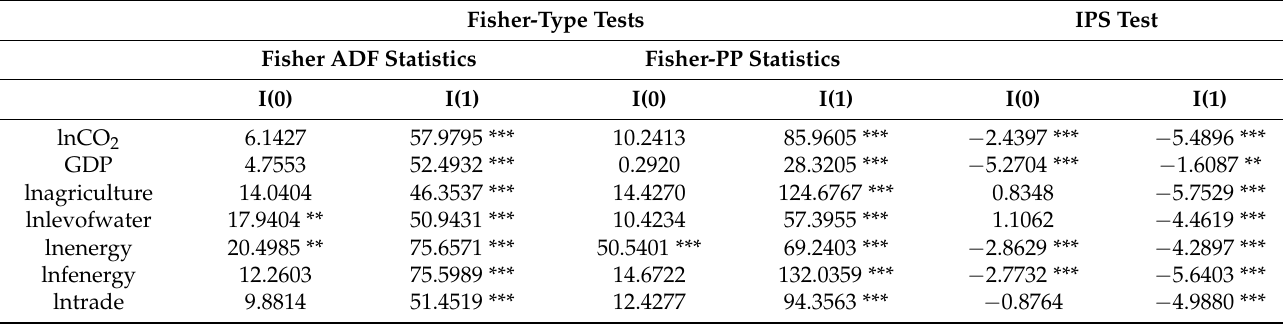
Table 4. Panel Unit Root tests.